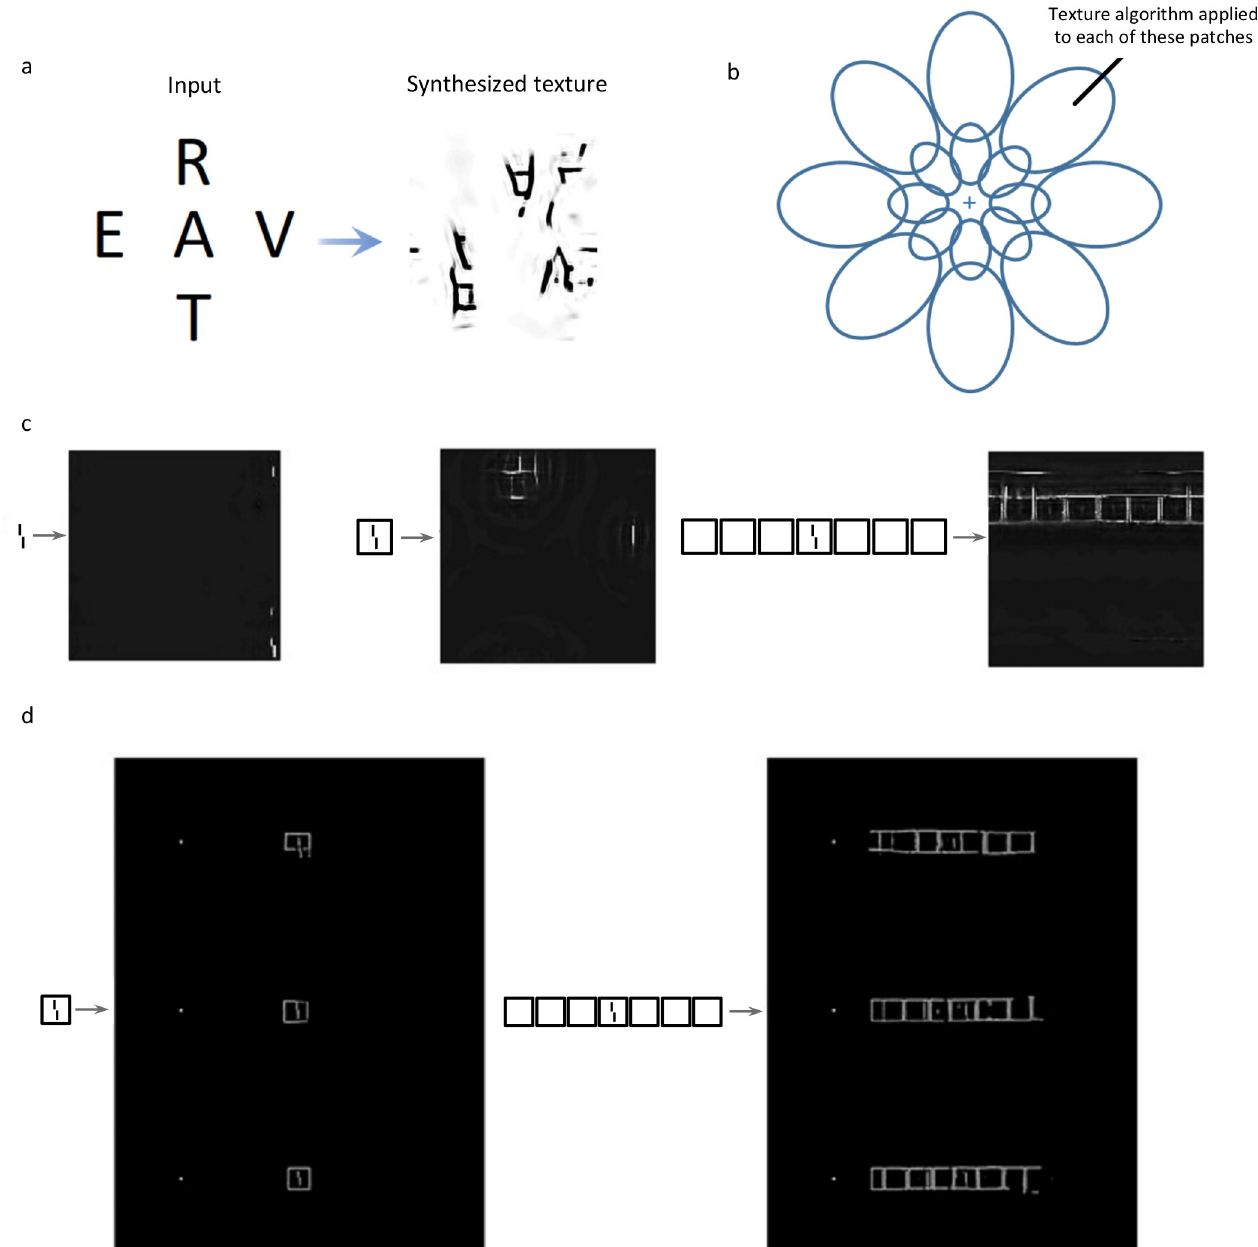
Fig 6. Texture Synthesis and Texture Tiling Model. a. A texture (right) synthesized from the input on the left using the Portilla & Simoncelli [29] summary statistics. The output resembles crowding. Pooling- and substitution-like effects occur. b. In the TTM, instead of applying the summary statistics process to the whole image at once, only local patches of the image are processed, yielding a local summary statistics model. The local patches are thought to reflect V2 receptive fields. c. Whole-field summary statistics. From left to right: stimuli and Portilla & Simoncelli textures for the vernier, 1-square and 7-square conditions. The vernier offset is easy to determine from the texture in the vernier alone condition, and slightly harder in the crowded condition (a right-offset is discernable in the middle top of the display). Across all data, the model consistently produces crowding, but no uncrowding, as exemplified in the right condition in which no offset is present at all. d. Texture Tiling model. The left column shows three synthesized examples from the 1-square condition. On the right is the 7-flanking squares case. The model cannot produce uncrowding: since the stimulus on the right is less crowded than the stimulus on the left in the human data, the direction of the vernier should be easier to make out on the right than on the left. However, this is not the case.